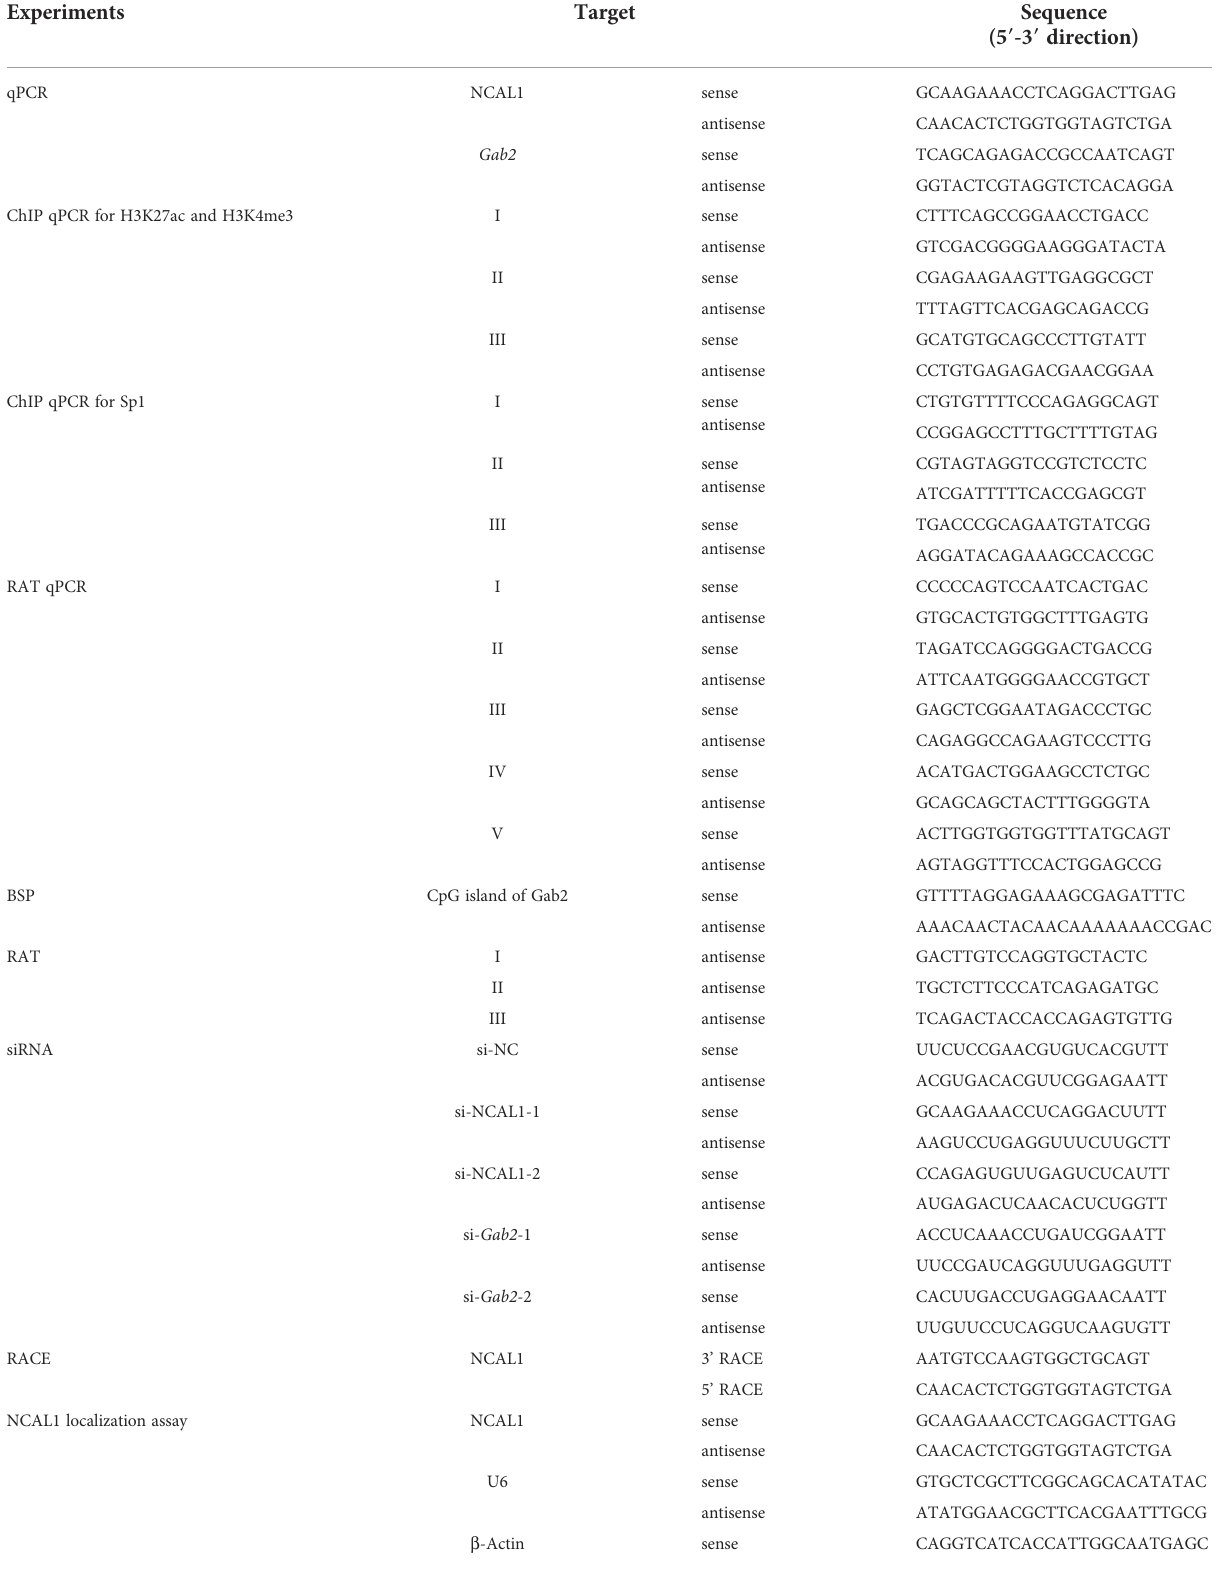
TABLE 1 Primers used in the